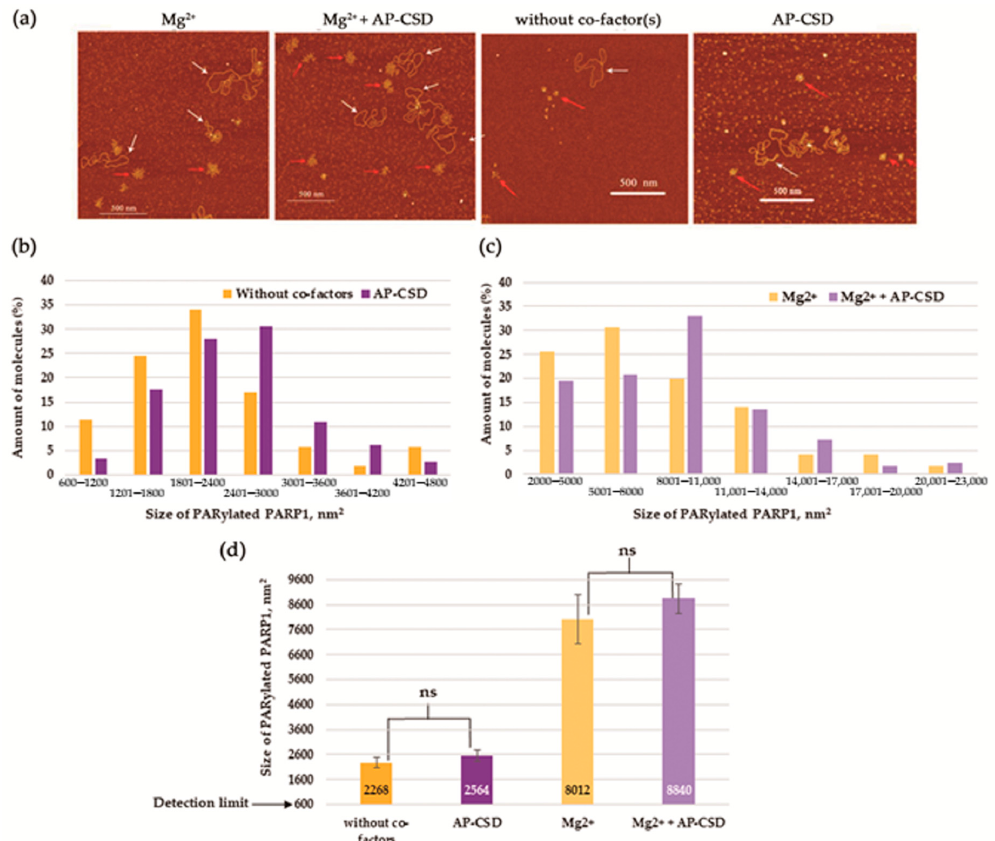
Figure 10. AFM-based analysis of PARylated PARP1 showing the molecular size distributions in the presence of the AP-CSD fragment. ( a ) AFM images show auto-PARylation of PARP1 in the presence of Mg 2 + , in the presence of Mg 2 + and AP-CSD, without co-factors, and in the presence of AP-CSD. White arrows indicate plasmid DNA molecules and red arrows indicate PARylated proteins. Scale bar: 500 nm; Z scale: 5 nm. ( b , c ) The percentage histograms showing the percentage of PARylated molecules in each size range in the presence of Mg 2 + ( c ), in the presence of Mg 2 + and AP-CSD fragment ( c ), without co-factors ( b ), and in the presence of AP-CSD fragment ( b ). Number of PARylated molecules analyzed: 89 for Mg 2 + , 84 for Mg 2 + and AP-CSD fragment, 82 for without co-factors, and 93 for AP-CSD fragments. The area of minimum ellipse enclosing the PARylated protein was used to estimate the area of PARylated proteins. The size of PARylated PARP1 smaller than 600 nm 2 was not taken into account. ( d ) The average size of PARylated PARP1 measured in images shown in ( a ). Results are mean ± SD of two to five images of three independent samples for each assay group. p -values were obtained by comparing the results by Student’s t -test, ns, not significant.